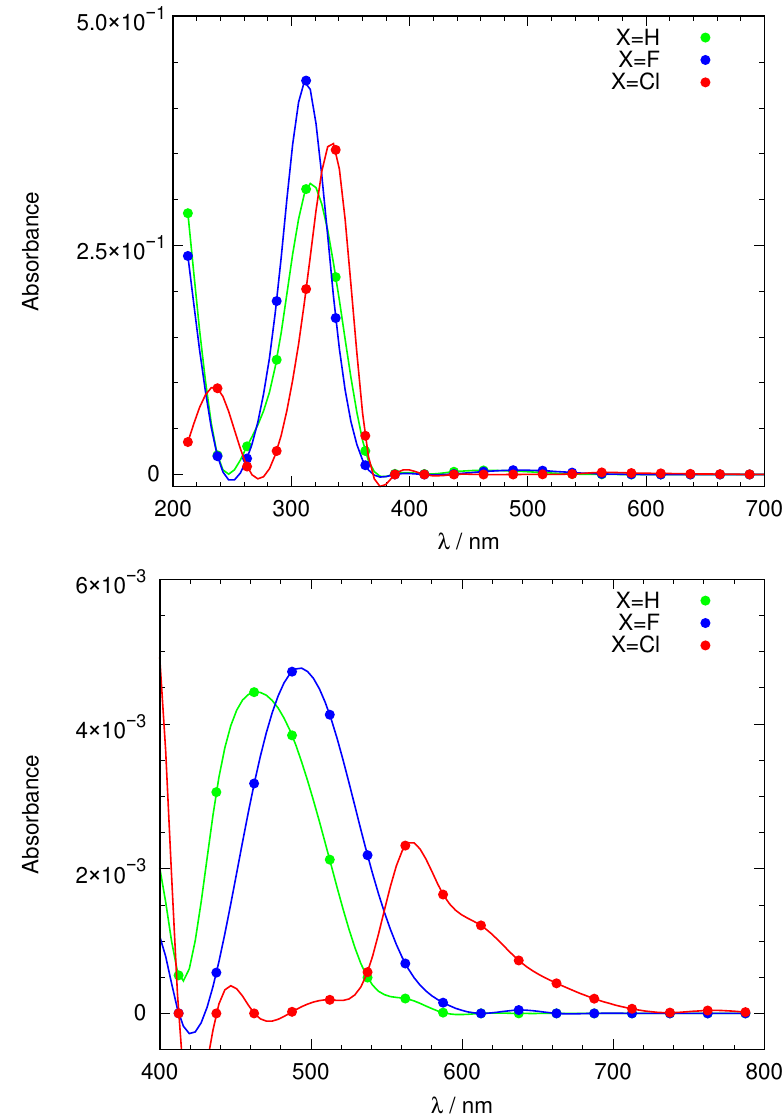
Figure 6. Simulation of the absorption spectra of azobenzene derivatives (X=H, F and Cl) based on a QM/MM molecular dynamics simulation, where the solute is described using DFTB. Top: full range including UV and visible spectra featuring the transition to S 2 ; Bottom: visible part of the spectrum highlighting the weak transition to S 1 . Absorbance is given in arbitrary